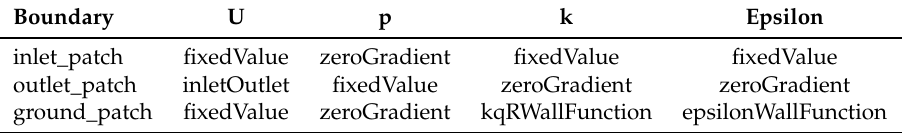
Table 2. The boundary condition types used for OpenFOAM model in the